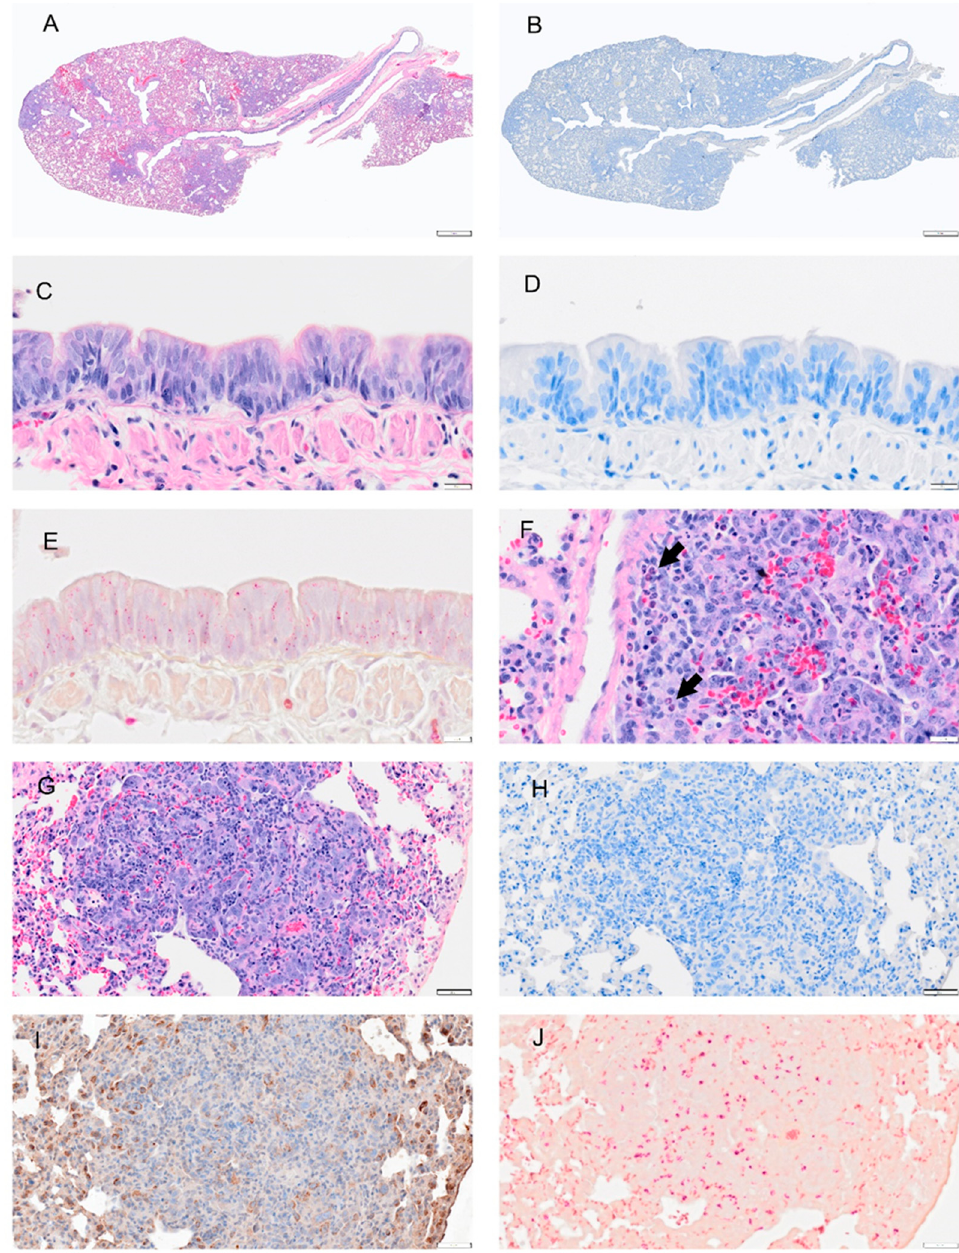
Figure 8. Selected pathology and immunohistochemistry of lungs from Syrian hamsters at 8 dpi with SARS-CoV-2. ( A ) H&E section shows well demarcated areas of consolidation and multifocal hemorrhage. ( B ) A representative section of the lung was subjected to IHC for the discovery of viral antigens. No staining for viral antigen was observed. ( C ) A higher magnification image of bronchial epithelial cells shows hyperplasia and few inflammatory cells ( D ). No viral staining was detected in adjacent serial section to ( C ). ( E ) A representative image stained with NACE stain shows no neutrophils in mucosa or submucosa. ( F ) H&E imaging shows increased eosinophils and neutrophils in the interstitial tissues (arrow) of the lung. Alveolar epithelial are hypertrophic and hyperplastic. ( G ) Representative section of the lung showing alveolar bronchiolization and inflammatory cell infiltration. ( H ) An adjacent section of ( G ) probed by IHC for viral antigen. No viral antigen was detected. ( I ) An adjacent serial section to (G/H) probed for prosurfactant protein C. IHC shows positive signals in cytoplasm of proliferating type 2 alveolar cells. ( J ) An adjacent serial section to (G/H) stained with NACE stain and shows neutrophils in these foci. Scalebar: ( A , B ) = 1 mm; ( C – F ) = 20 µ m; ( G – J ) = 50 µ